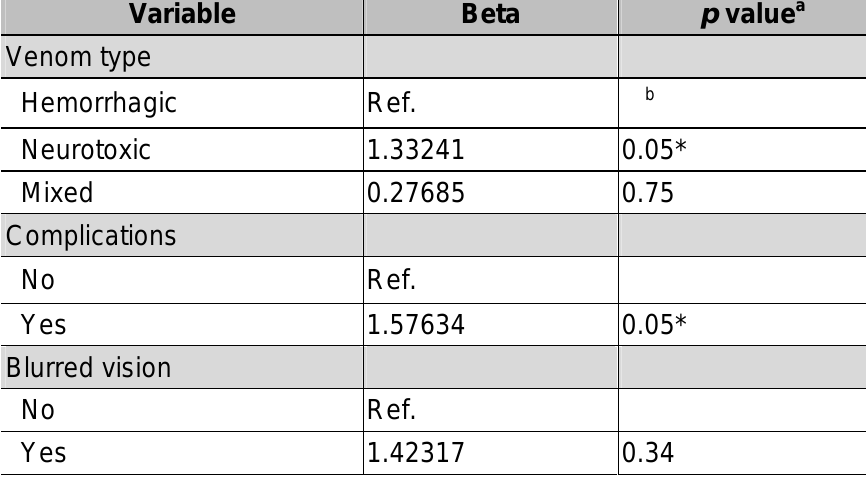
Table 3 . Linear regression analysis of the association between antivenom dose and effectors in 58 patients who received treatment in the medical center of Taiwan,